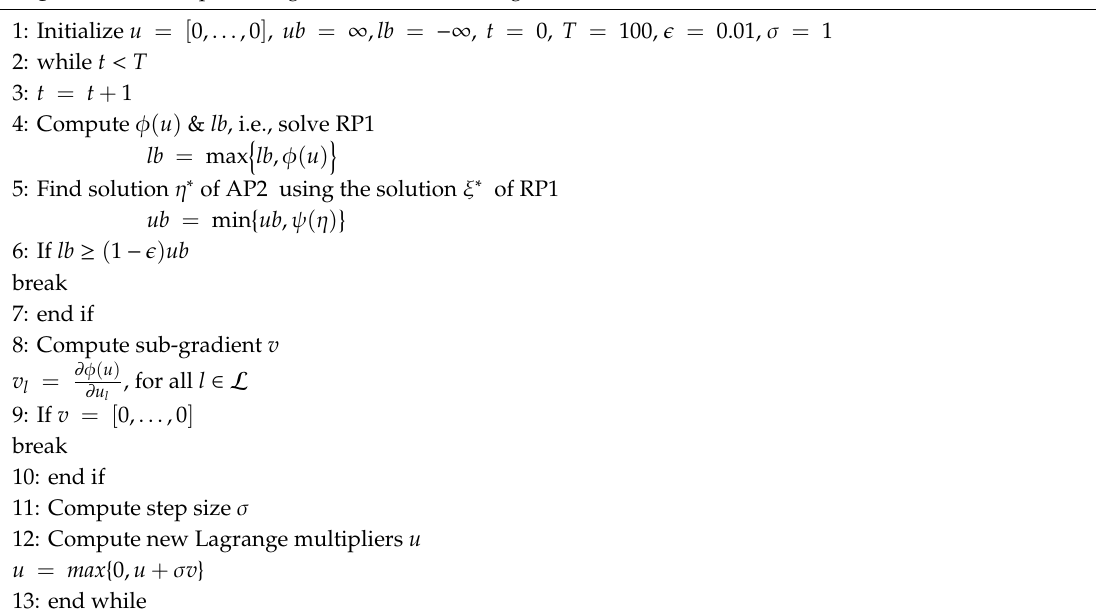
Algorithm 1 Sub-optimal algorithm based on sub-gradient